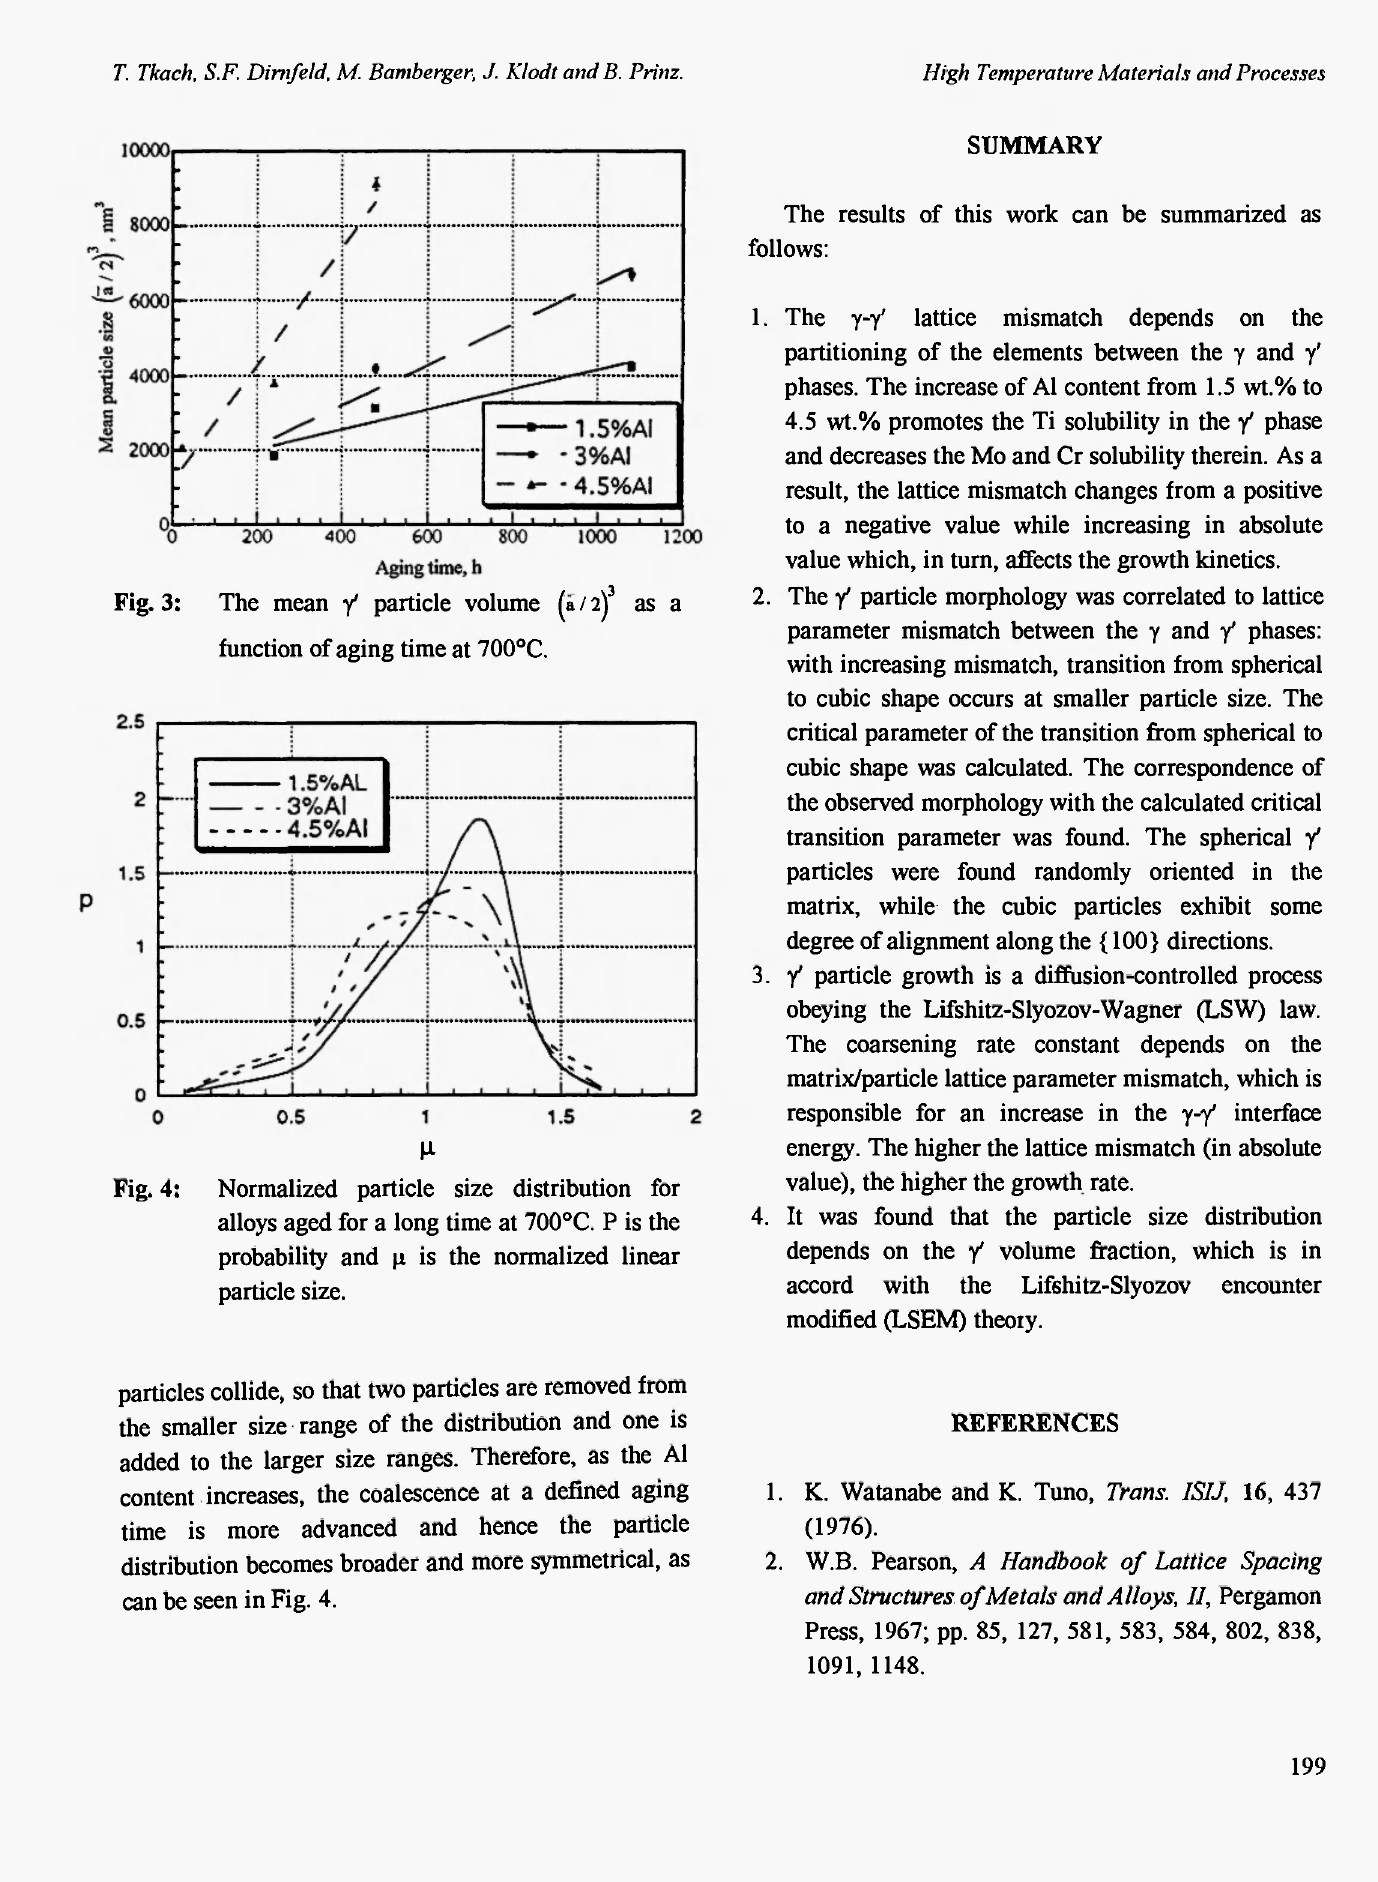
Fig. 3: The mean γ particle volume (a / 2) 3 as a function of aging time at 700°C.